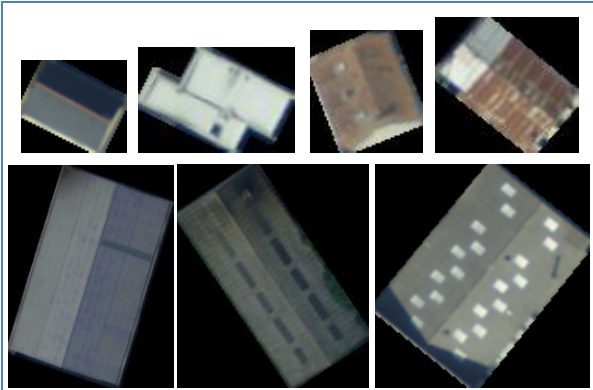
Figure 1. Examples of 20 cm resolution aerial images in real